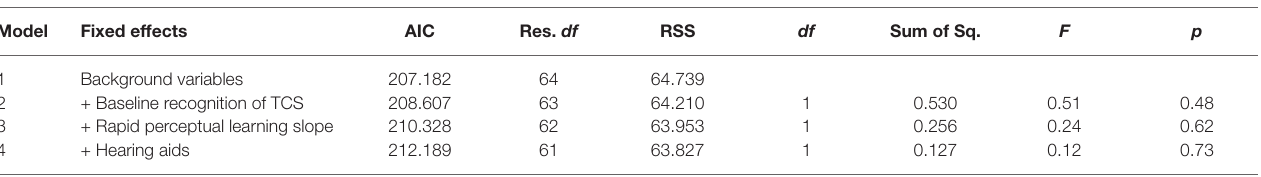
TABLE 9 | Dichotic gap—results of the comparison of nested model tests.